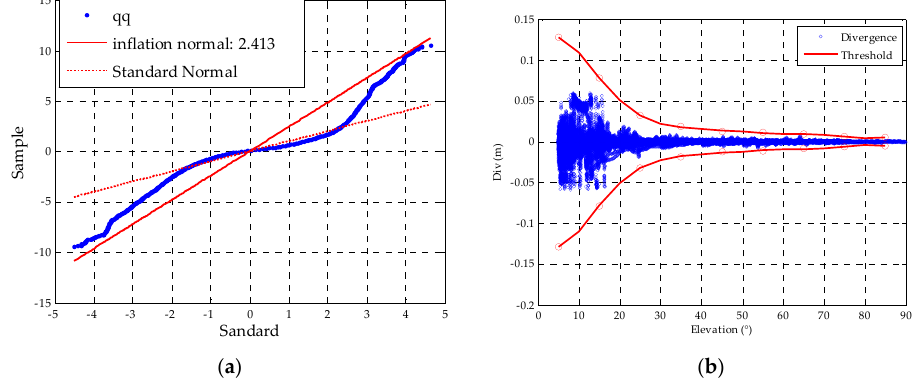
Figure 7. ( a ) Quantile-quantile plot for the inflation factor; ( b ) distribution of the test statistics with respect to satellite elevations and the resultant thresholds.